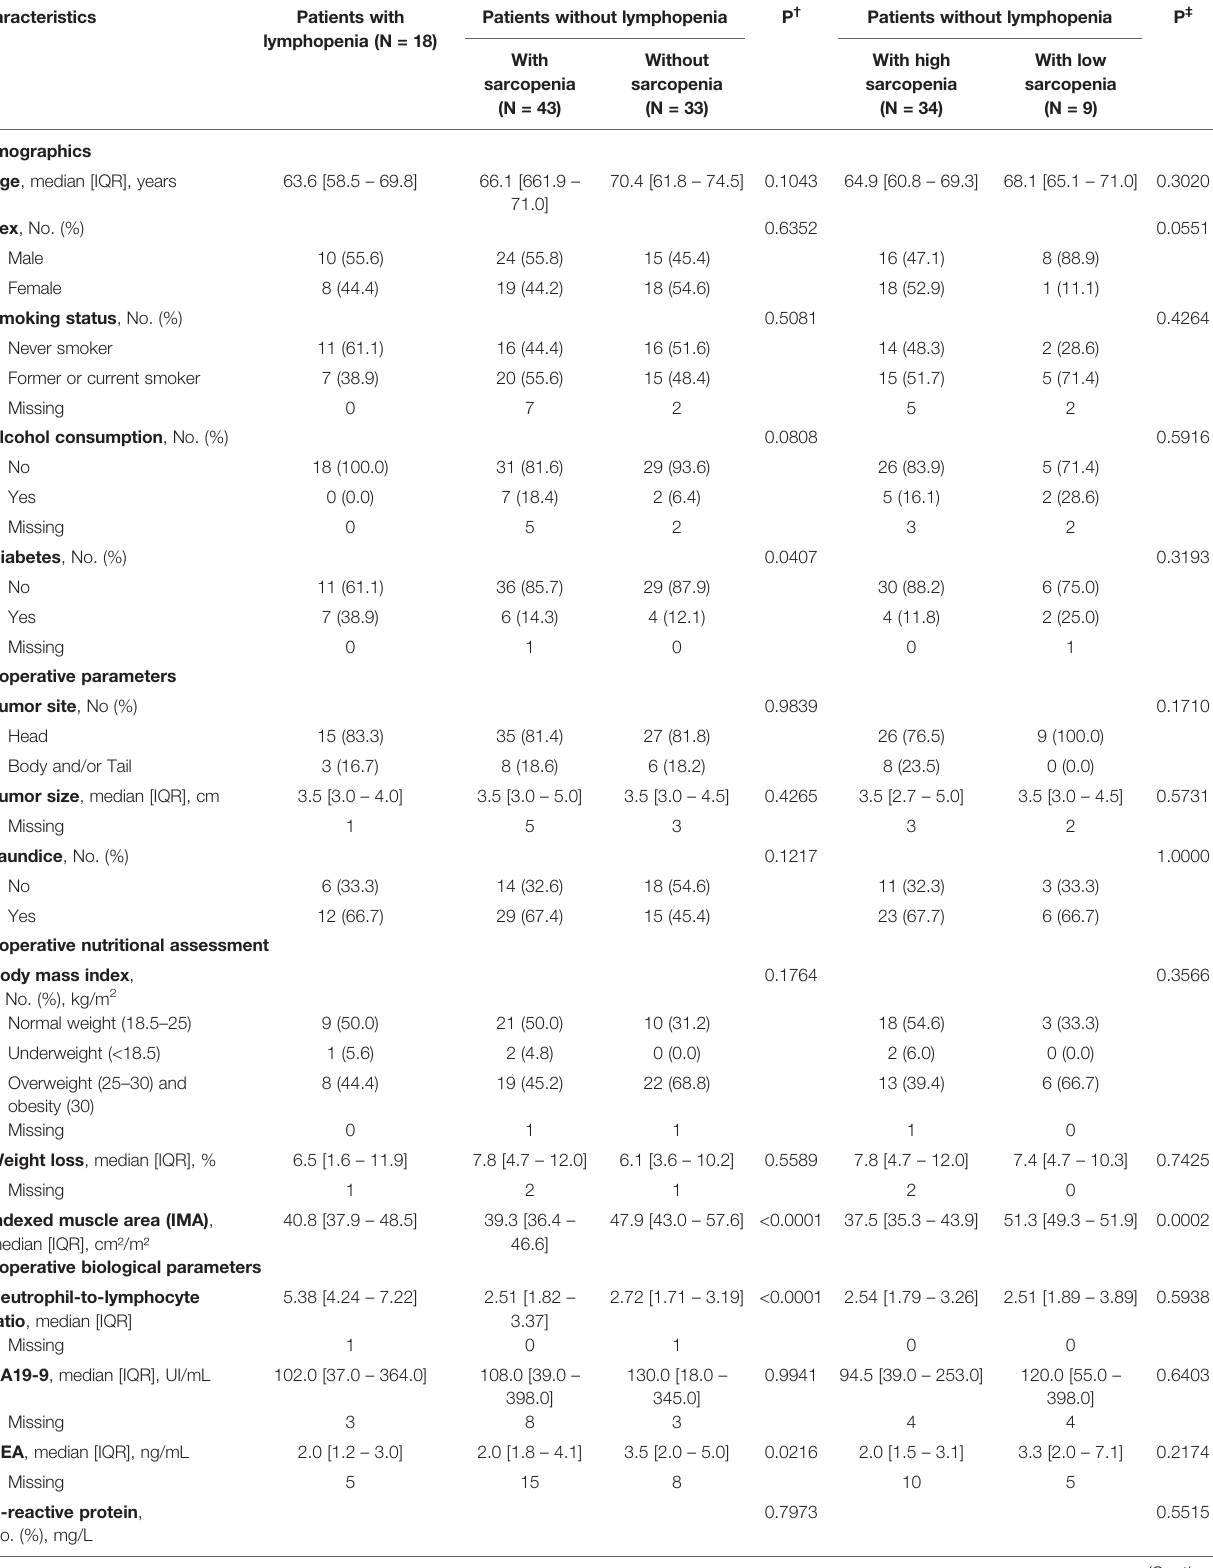
TABLE 4 | Patient characteristics in each risk group.